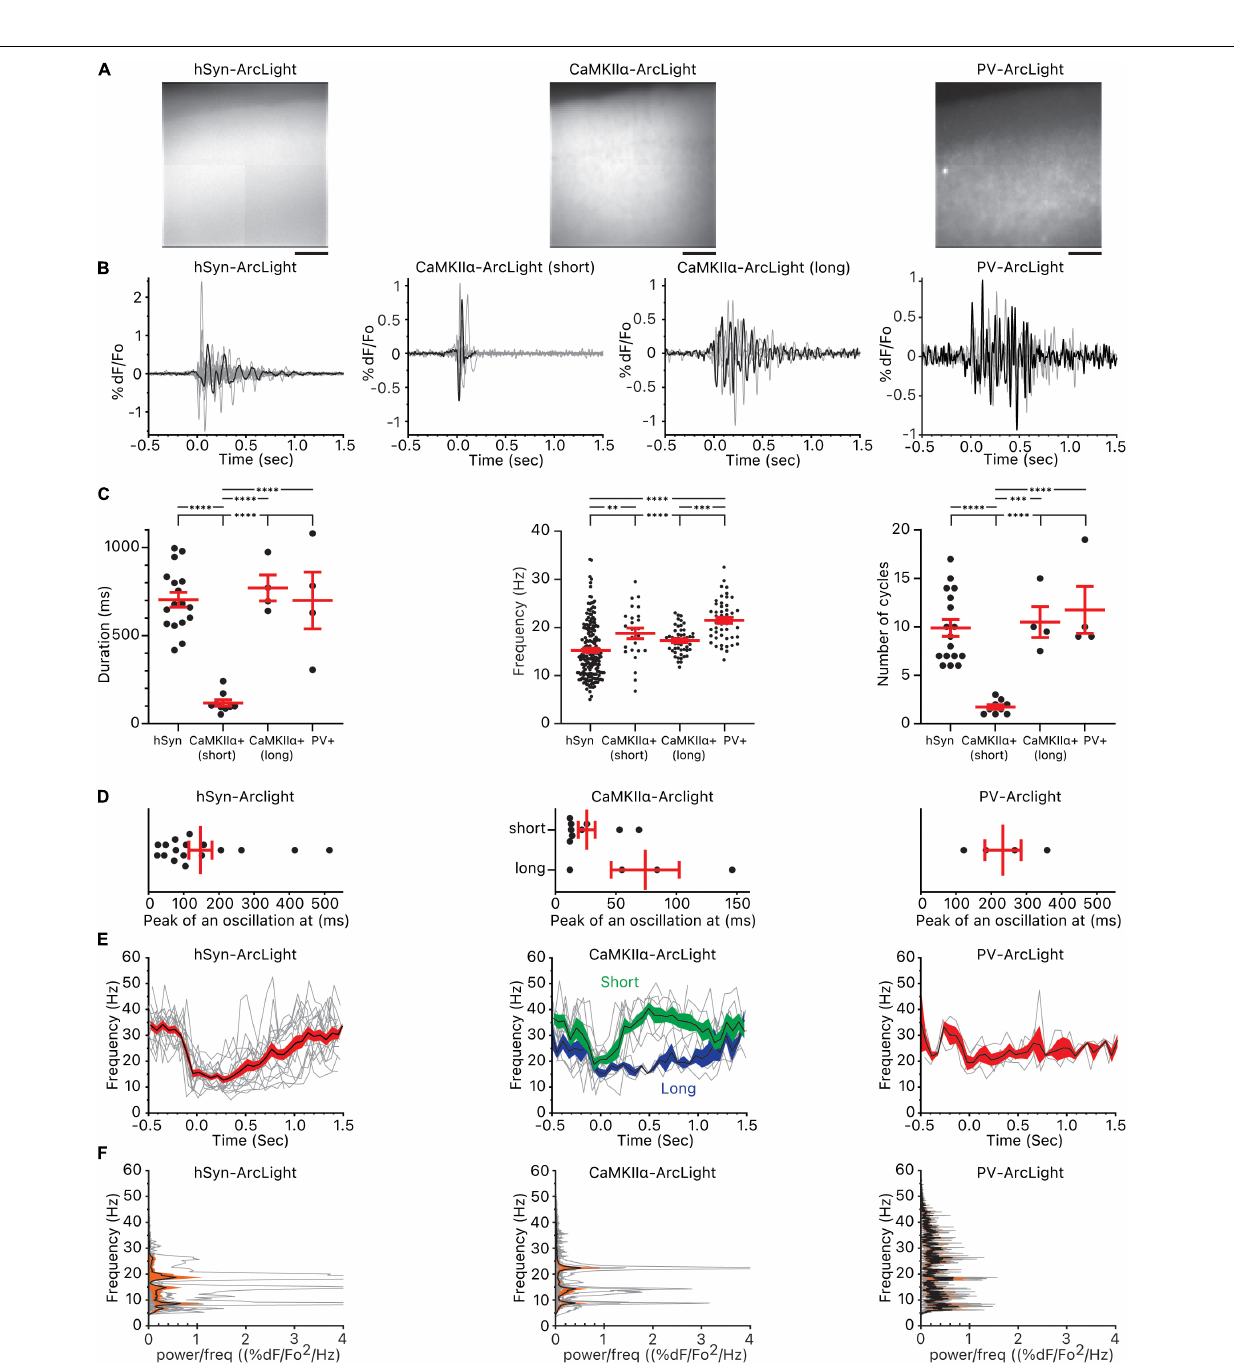
Frontiers in Neuroanatomy |